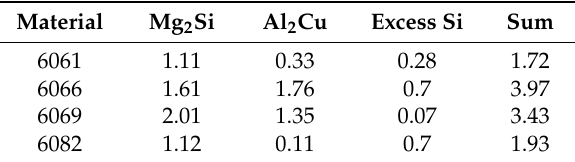
Figure 6. Phase diagrams of ( a ) Al–Si; ( b ) Al–Mg 2 Si; and ( c ) Al–Cu. Table 3. Weight ratios of Mg 2 Si and Al 2 Cu in Al–Mg–Si alloys (wt. %). Material